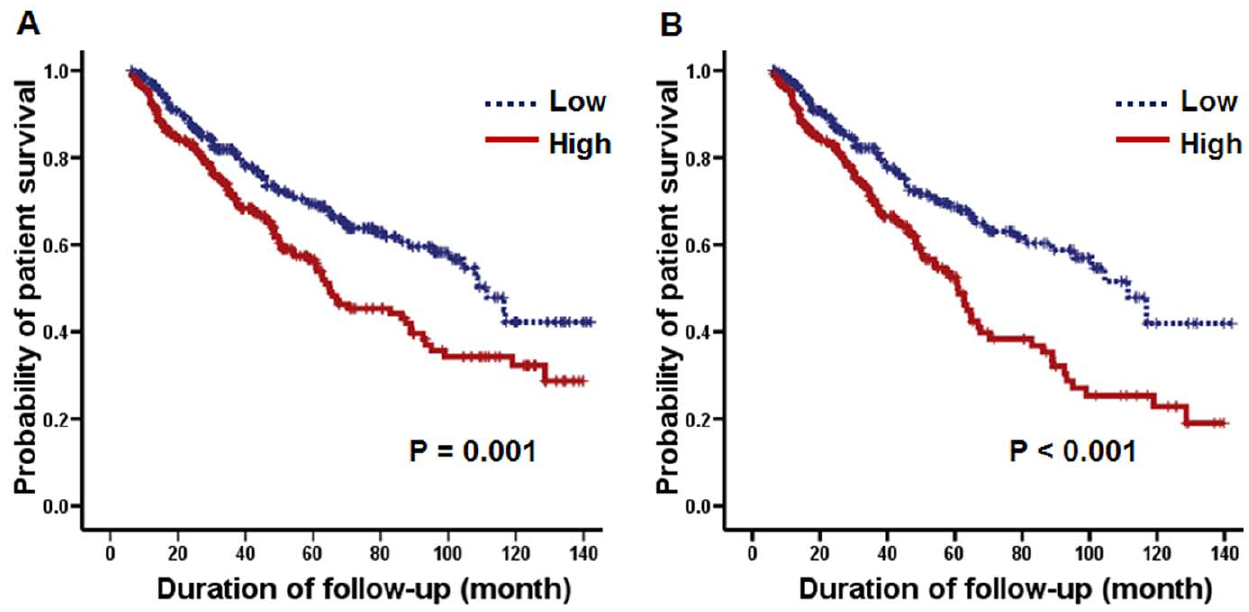
Figure 2. Kaplan-Meier plots for patient survival based on the median level (89.4 ml/day) of baseline peritoneal protein clearance. (A) Intention-to-treat analysis. (B) As-treated analysis.